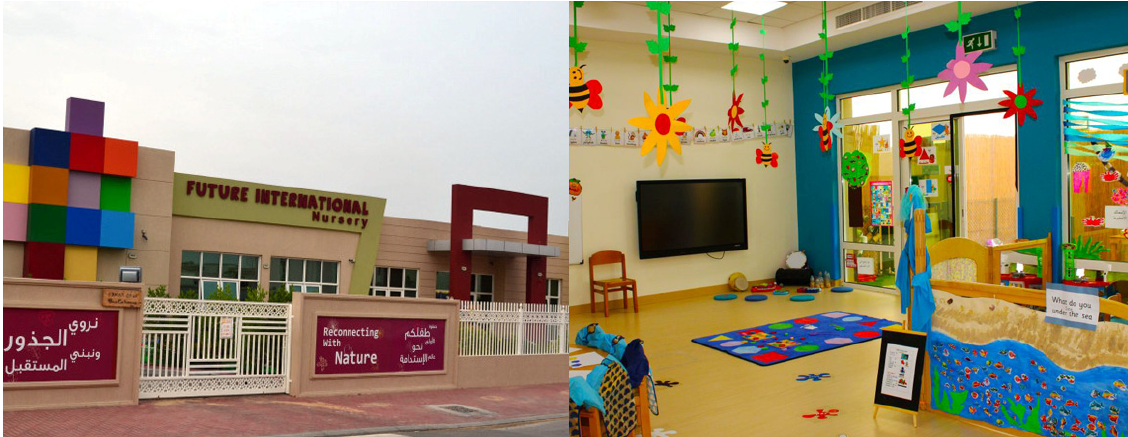
Figure 2. 01 ‐ FU Nursery Exterior and Interior View. Figure 2. 01-FU Nursery Exterior and Interior